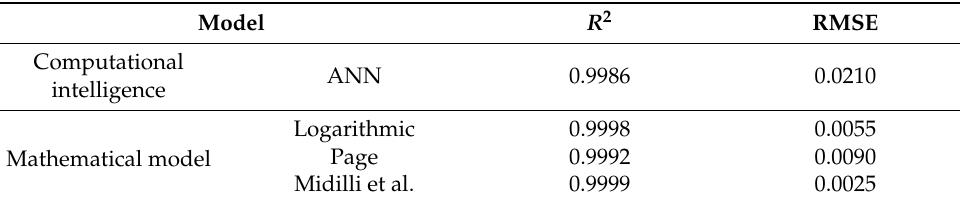
Table 5. Statistical results of drying kinetics of linden leaf samples for computational intelligence and mathematical models using IRD.